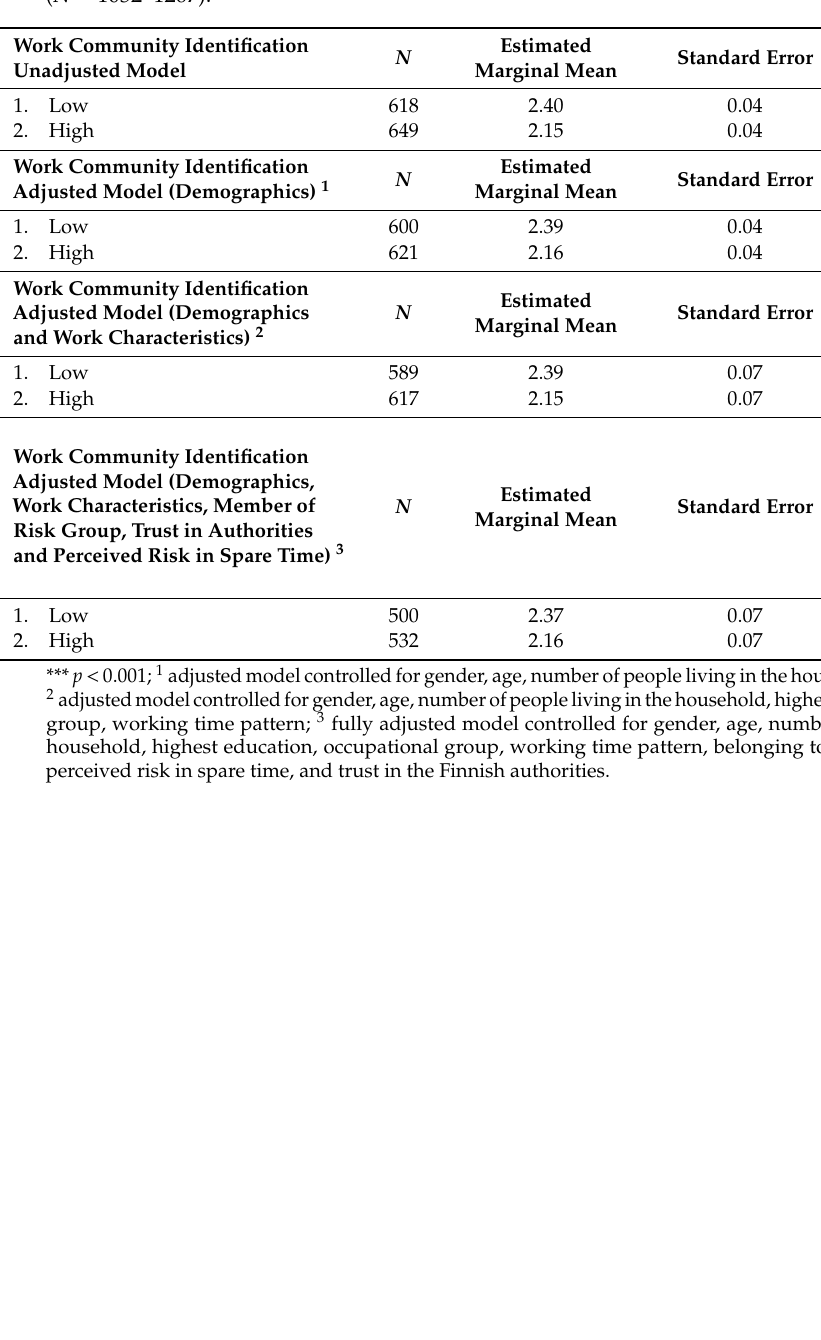
Table 3. Unadjusted and adjusted e ff ects of work community identification on stress symptoms ( N =